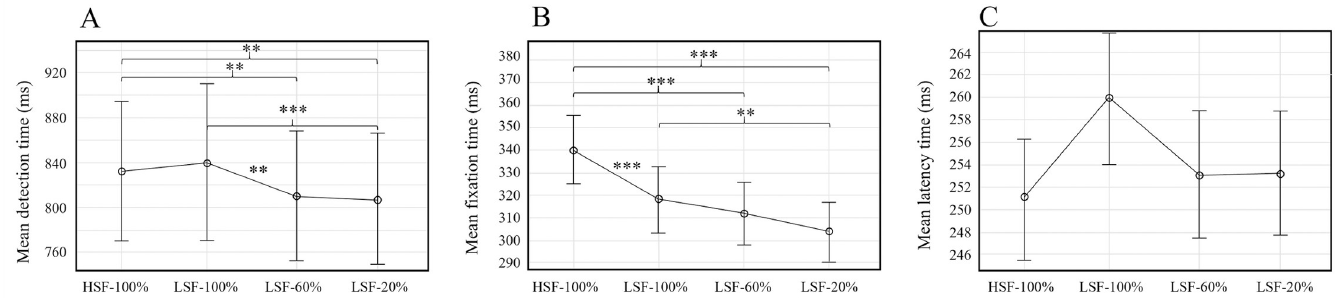
Fig 11. From left to right respectively, mean times for detection (A), fixation (B) and latency (C) as a function of the characteristics of the binocular background. Error bars represent standard error and main effects are indicated as follows: � p < 0.05, �� p < 0.01 and ��� p <